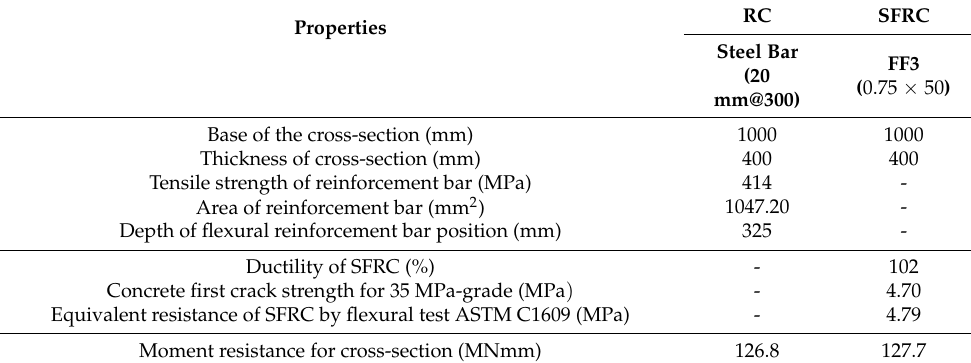
Figure 4. Example of test curves of steel fibre reinforced concrete (SFRC) for dosage rates of 0–40 kg/m 3 : ( a ) FF1 type; ( b ) FF3 type. Table 2. Flexural comparison of conventional reinforced concrete (RC) and